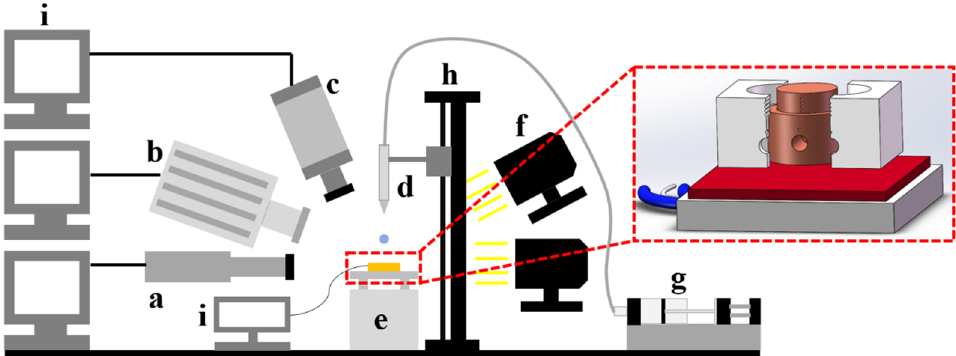
Figure 3. Experimental system of droplet impact. Two high speed cameras ( a , b ); ( c ) infrared thermal imager; ( d ) droplet generating device; ( e ) heating platform; ( f ) light source; ( g ) microsyringe pump; ( h ) linear displacement slide; ( i ) data acquisition computer.